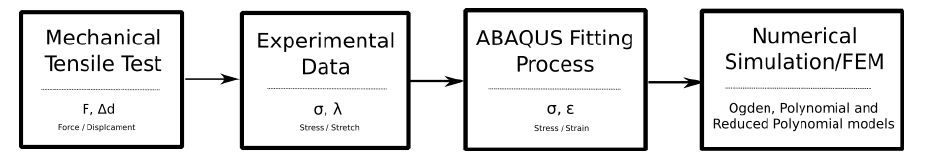
Figure 1. Workflow adopted.